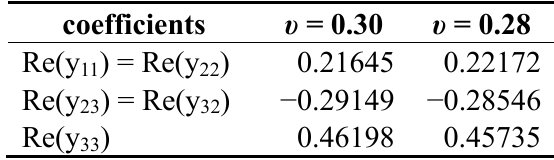
Table 1. The numerical values of coefficients for